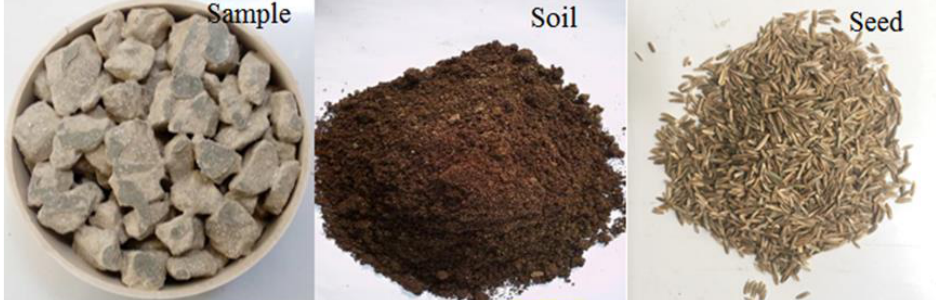
Figure 9. MPC-based porous ecological concrete sample, soil and seeds.